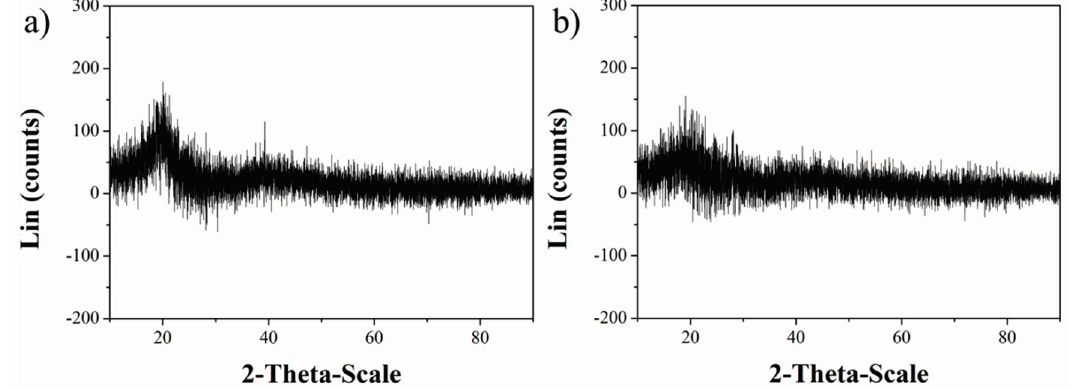
Figure 3. Film X-ray diffraction (XRD) patterns of BF